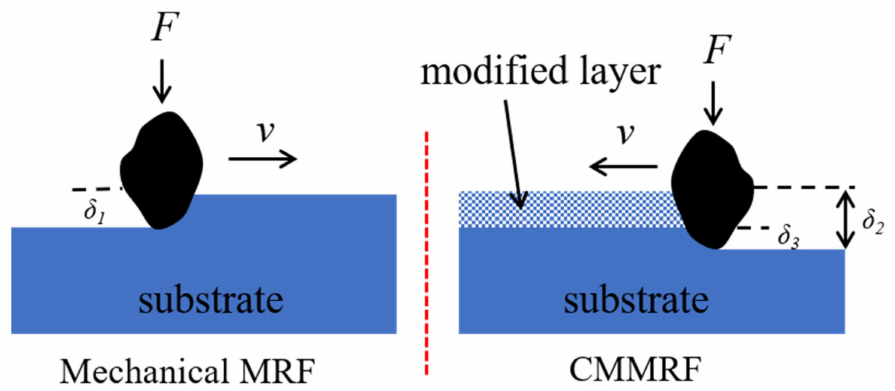
Figure 10. Abrasive contact model of mechanical MRF and